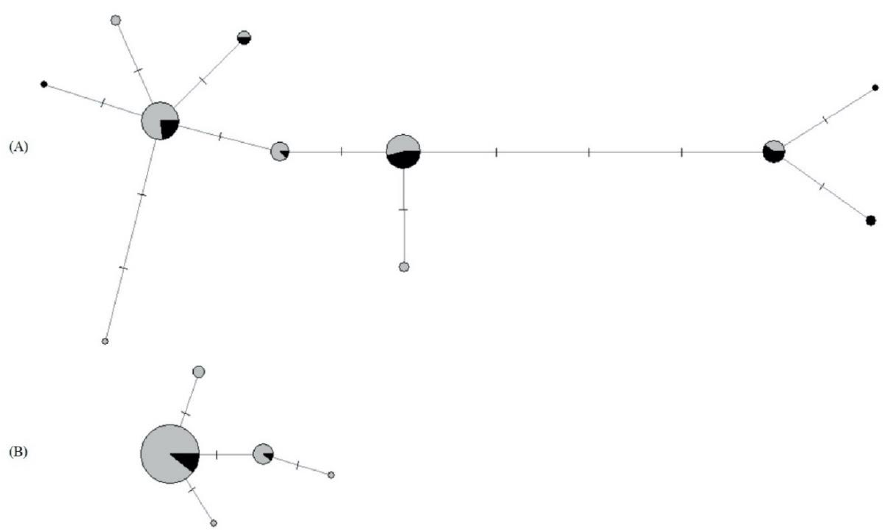
Figure 4. CO1gene haplotype network for ( A ) A. urticae samples and ( B ) P. confusa samples. Circle size is relative to the proportion of each haplotype in the sample. Mutational steps are indicated by lines. Individuals collected in the south of Sweden are in grey, individuals collected in the north of Sweden are in black. Table 4. Genetic variation within A. urticae and P. confusa populations estimated using CO1 mitochondrial gene and AFLPs. Sample size (N CO1 and N AFLP ), number of CO1 haplotype (N H ), number of polymorphic site (NPS), haplotype diversity (H d ), nucleotide diversity ( π ), percentage of variable markers (VM%), and gene diversity (Gdiv).